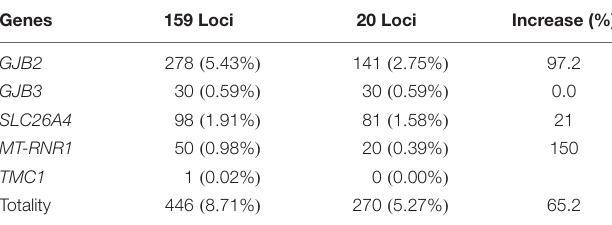
TABLE 7 | Comparison of genetic variants by expanded and conventional